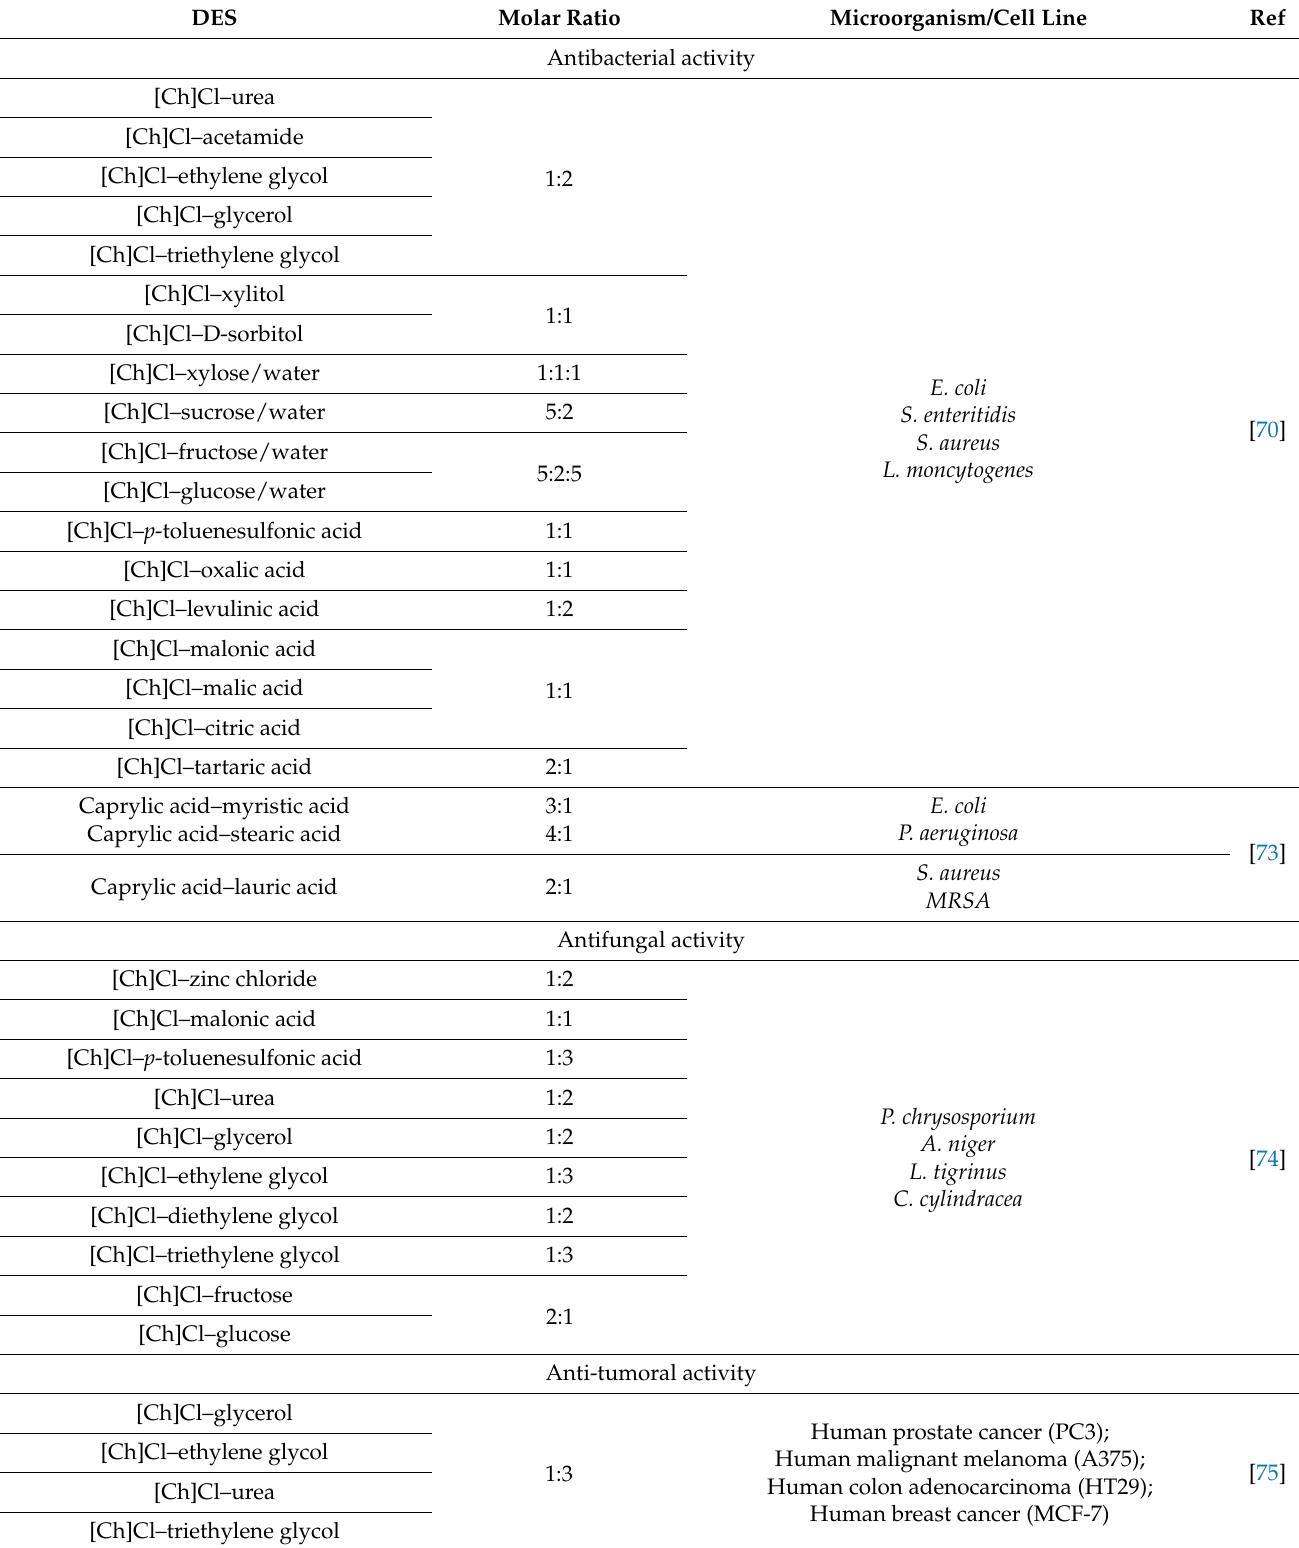
Table 4. DES’s biological activity and respective microorganisms and cell lines used in their study. DES Molar